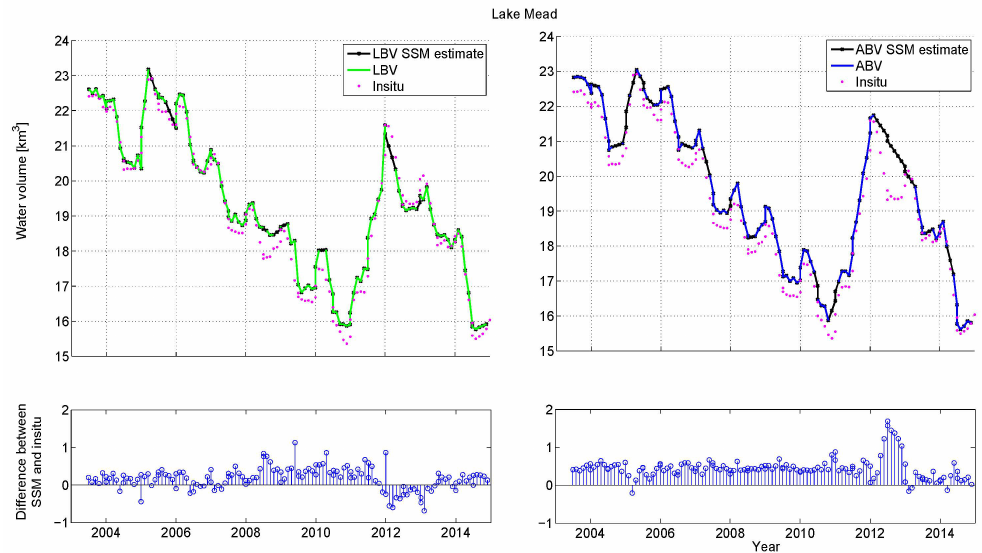
Figure 9. Missing data modification by SSM for the Lake Mead. ( Top left ) Landsat-bathymetry-volume (LBV) estimation and data gap filled by SSM; ( Bottom left ) difference between LBV-SSM estimates and in situ observations; ( Top right ) altimetry-bathymetry-volume (ABV) estimation and data gap filled by SSM; ( Bottom right ) difference between ABV-SSM estimates and in situ observations.